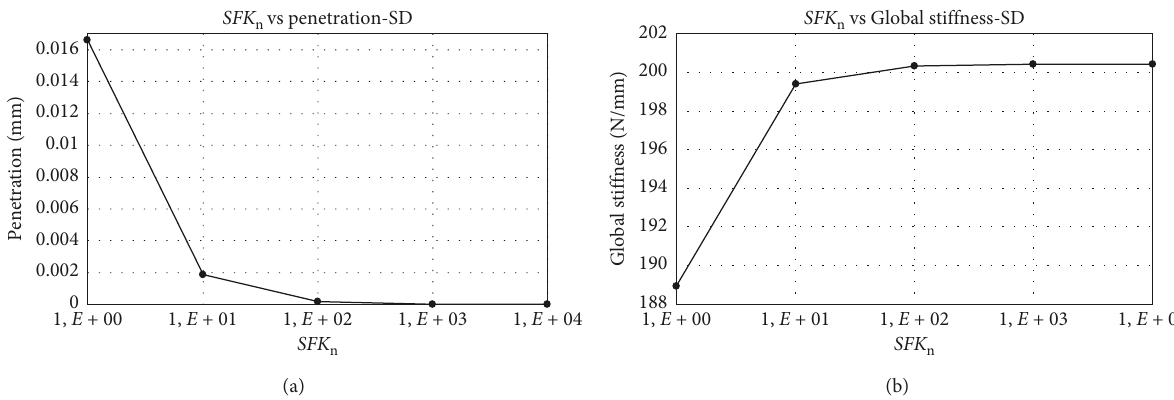
Figure 5: Penetration (a) and global stiffness (b) as a function of k